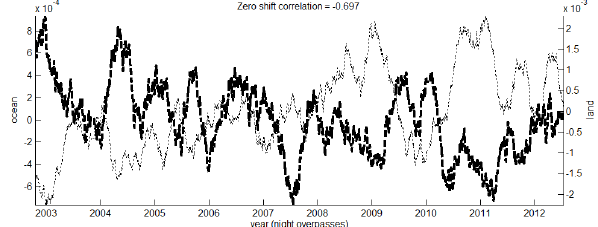
Figure 6. DCCw0 fraction anomalies of the night overpass data shown in Figure 5, smoothed with a 96- 681 Fig. 6. DCCw0 fraction anomalies of the night overpass data shown day running average. The bold trace refers to ocean, the light trace refers to land. 682 in Fig. 5. Bottom: DCCw0 fraction anomalies of the day overpass data. The bold trace refers to ocean; the light trace is for